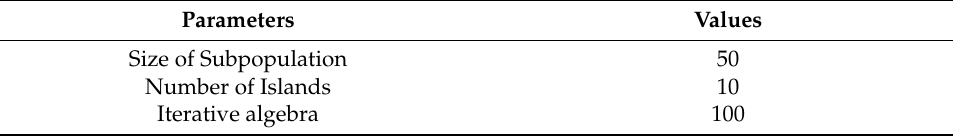
Table 7. Basic Parameters of multi-island